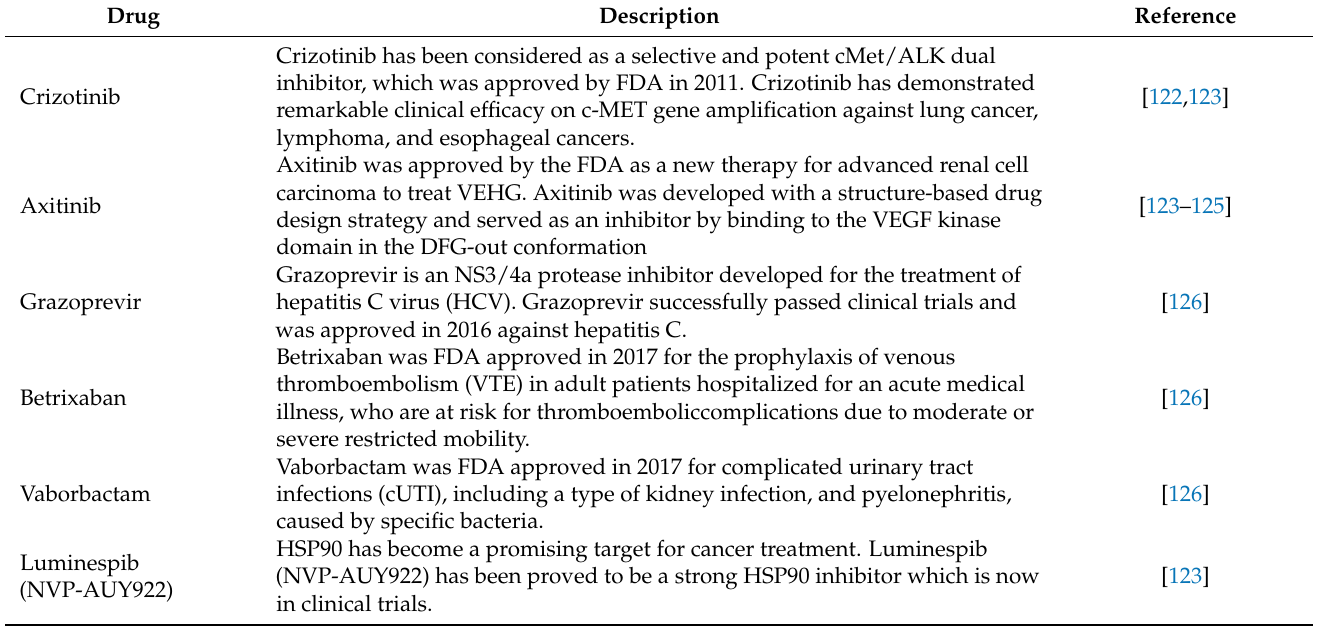
Table 2. Recent successful stories of computational drug discovery approved by FDA or in a clinical trial. For an extensive Table of commercial drugs that made use of computer-aided drug design during the discovery process see [121], while for a detailed list of proteins and phytocompounds for computational docking along with therapeutic potential see